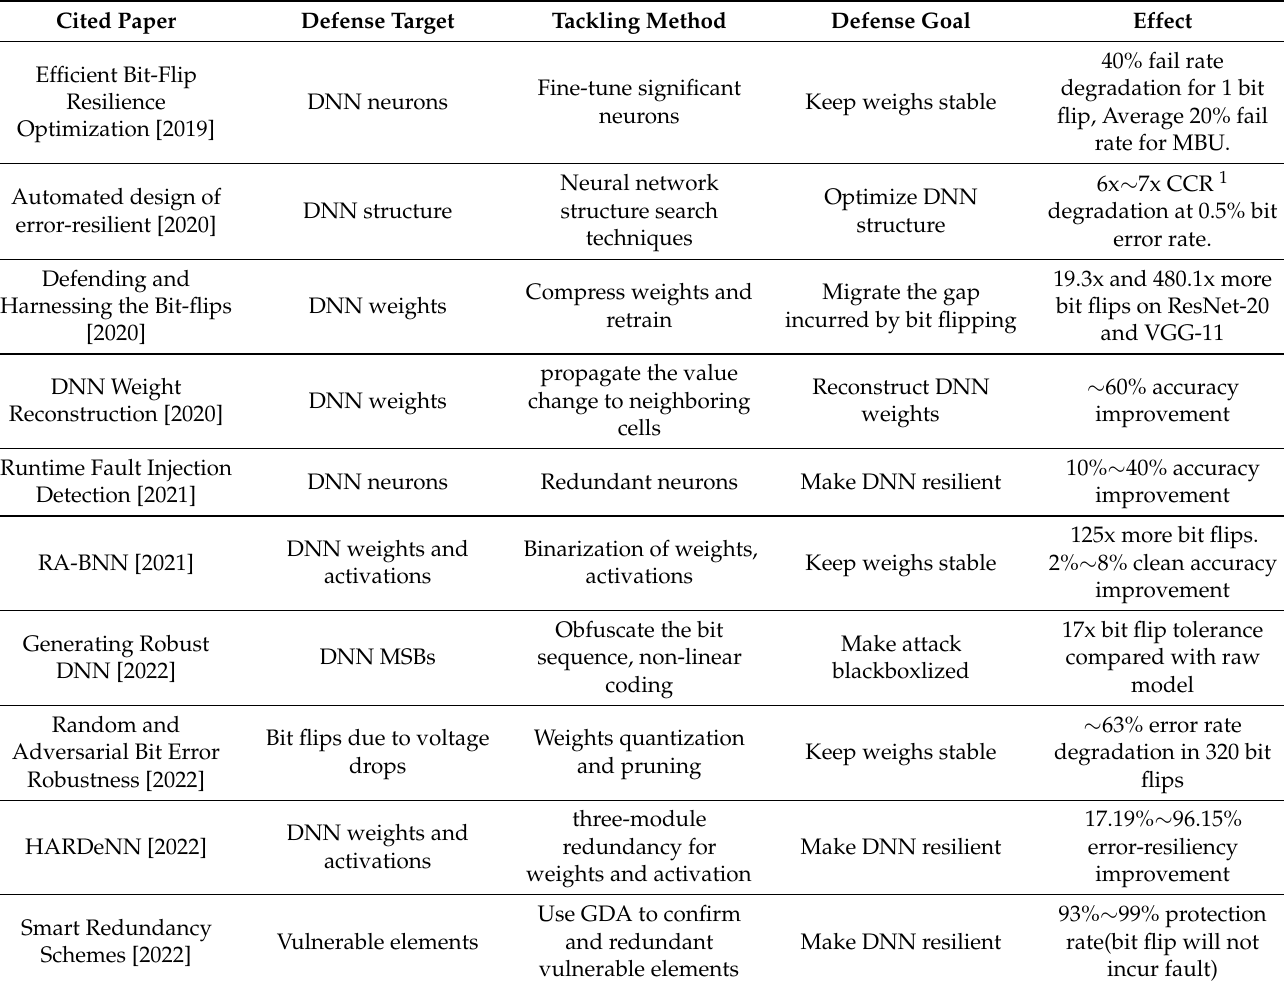
Table 8. The attributes of work that aims to lower the harmness of